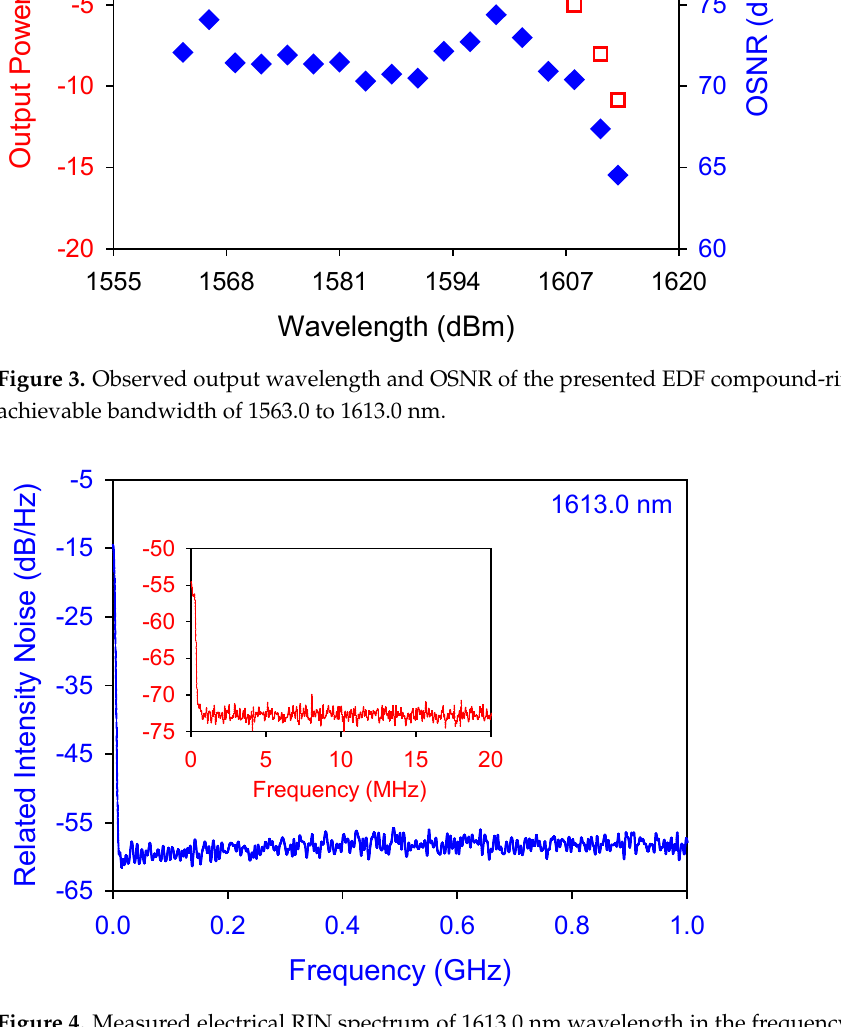
Figure 3. Observed output wavelength and OSNR of the presented EDF compound-ring laser in the achievable bandwidth of 1563.0 to 1613.0 nm.